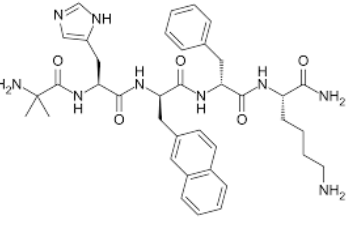
Figure 23. Chemical structure of ipamorelin. Formula: C 38 H 49 N 9 O 5 .